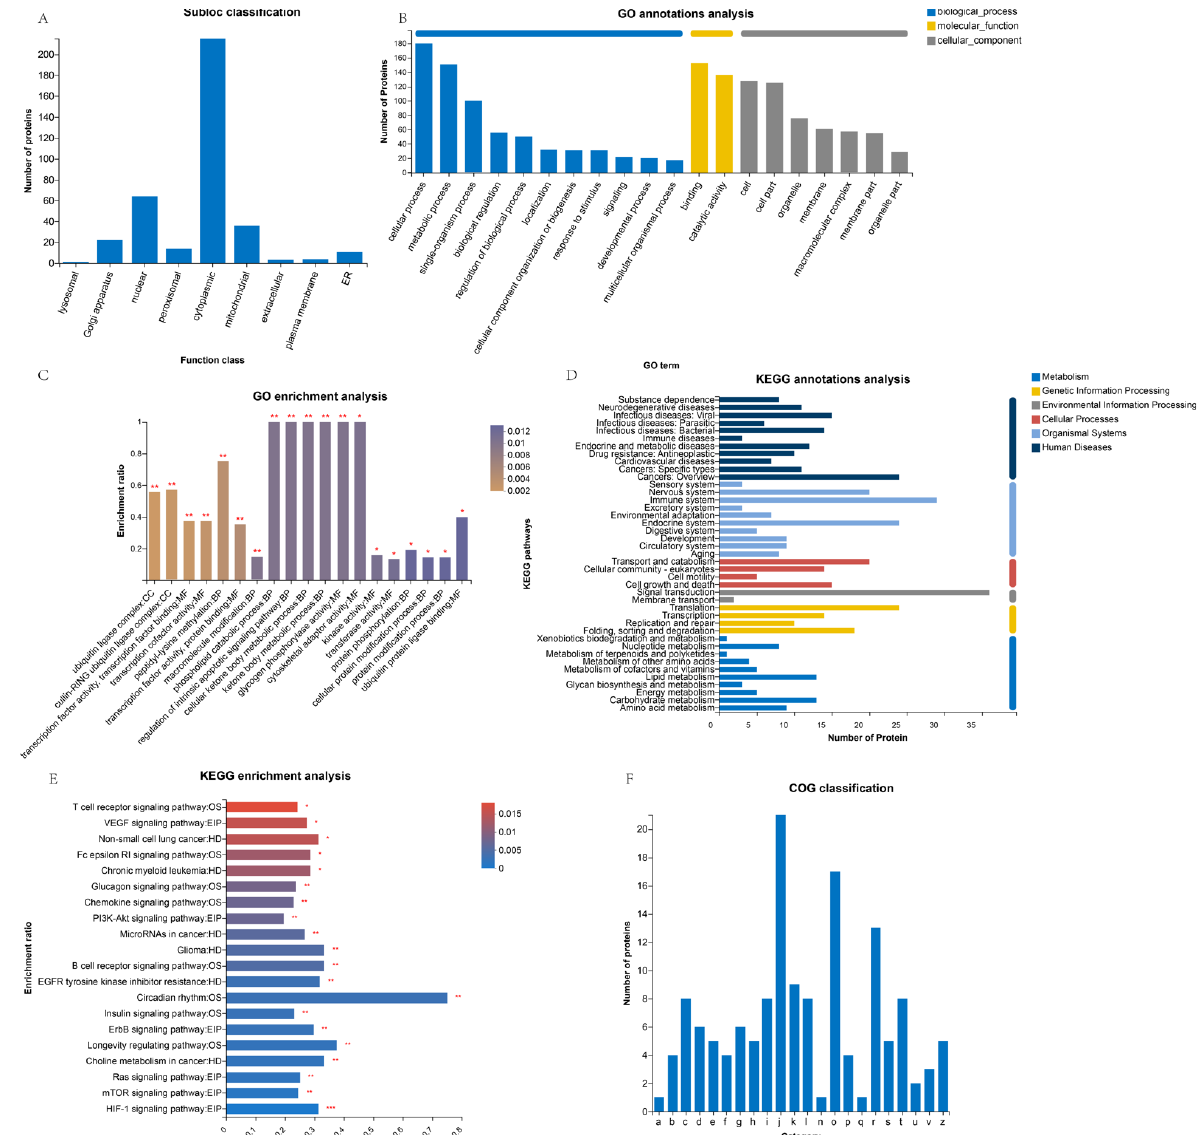
Figure 3. Bioinformatics analysis of DEPs from CCO cells with SHVV cultured in the glutamine-free medium or the complete medium. (A) Subcellular localization of DEPs. (B) GO annotations analysis of DEPs. (C) GO enrichment analysis of DEPs. (D) KEGG annotations analysis of DEPs. (E) KEGG enrichment analysis of DEPs. (F) COG analysis of DEPs. (a) RNA processing and modification; (b) Chromatin structure and dynamics; (c) Energy production and conversion; (d) Cell cycle control, cell division, chromosome partitioning; (e) Amino acid transport and metabolism; (f) Nucleotide transport and metabolism; (g) Carbohydrate transport and metabolism; (h) Coenzyme transport and metabolism;(i) Lipid transport and metabolism; (j) Translation, ribosomal structure and biogenesis; (k) Transcription; (l) Replication, recombination and repair; (n) Cell motility; (o) Posttranslational modification, protein turnover, chaperones; (p) Inorganic ion transport and metabolism; (q) Sec- ondary metabolites biosynthesis, transport and catabolism; (r) General function prediction only; (s) Function unknown; (t) Signal transduction mechanisms; (u) Intracellular trafficking, secretion, and vesicular transport; (v) Defense mechanisms; (z) Cytoskeleton. (*, p -value < 0.05; **, p -value < 0.01; ***, p -value <